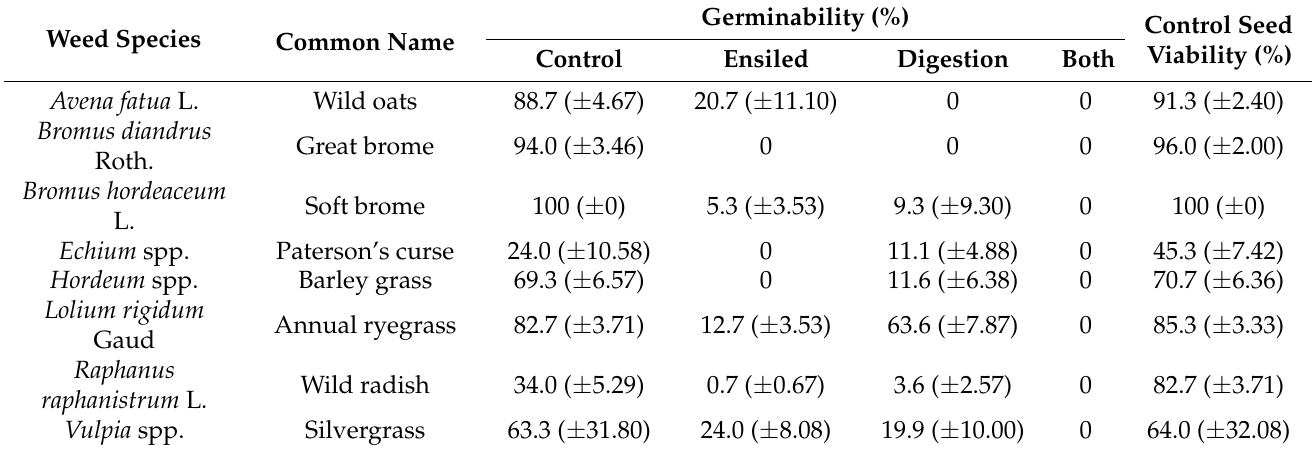
Table 1. Effect of ensiling, in sacco digestion or both on germinability of selected temperate weed species’ seeds. Weed